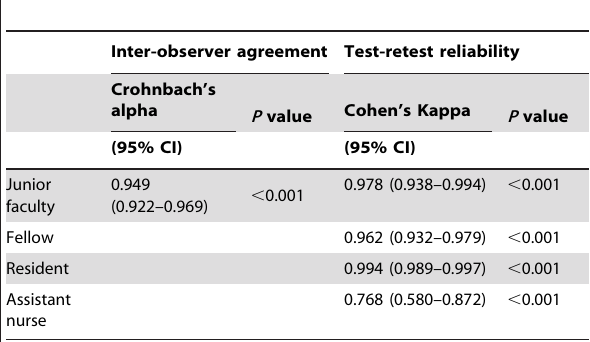
Table 3. Inter-observer and test-retest reliability of S-ReSC scores over a period of 2